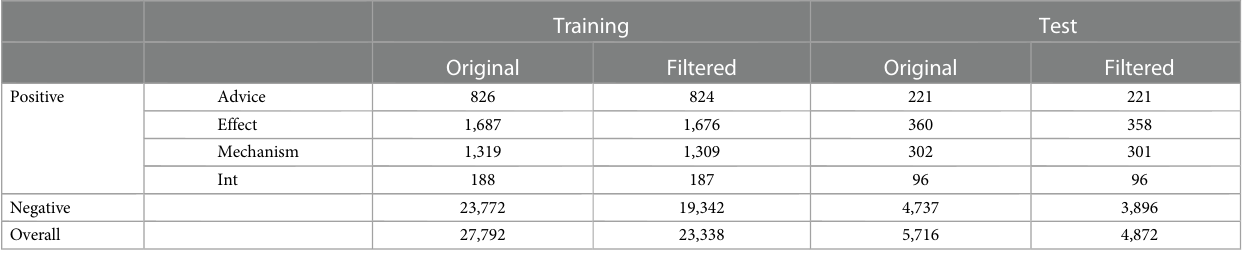
TABLE 2 The statistics of DDIExtraction-2013